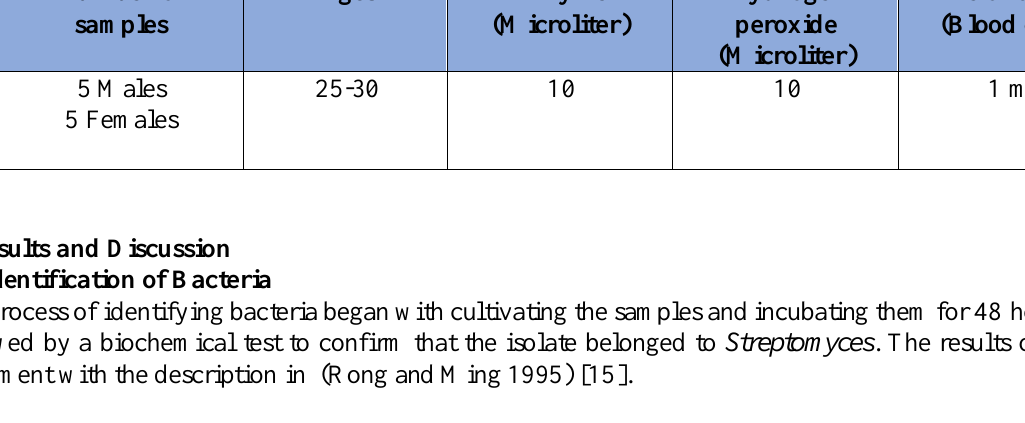
Table 1. Characteristics of